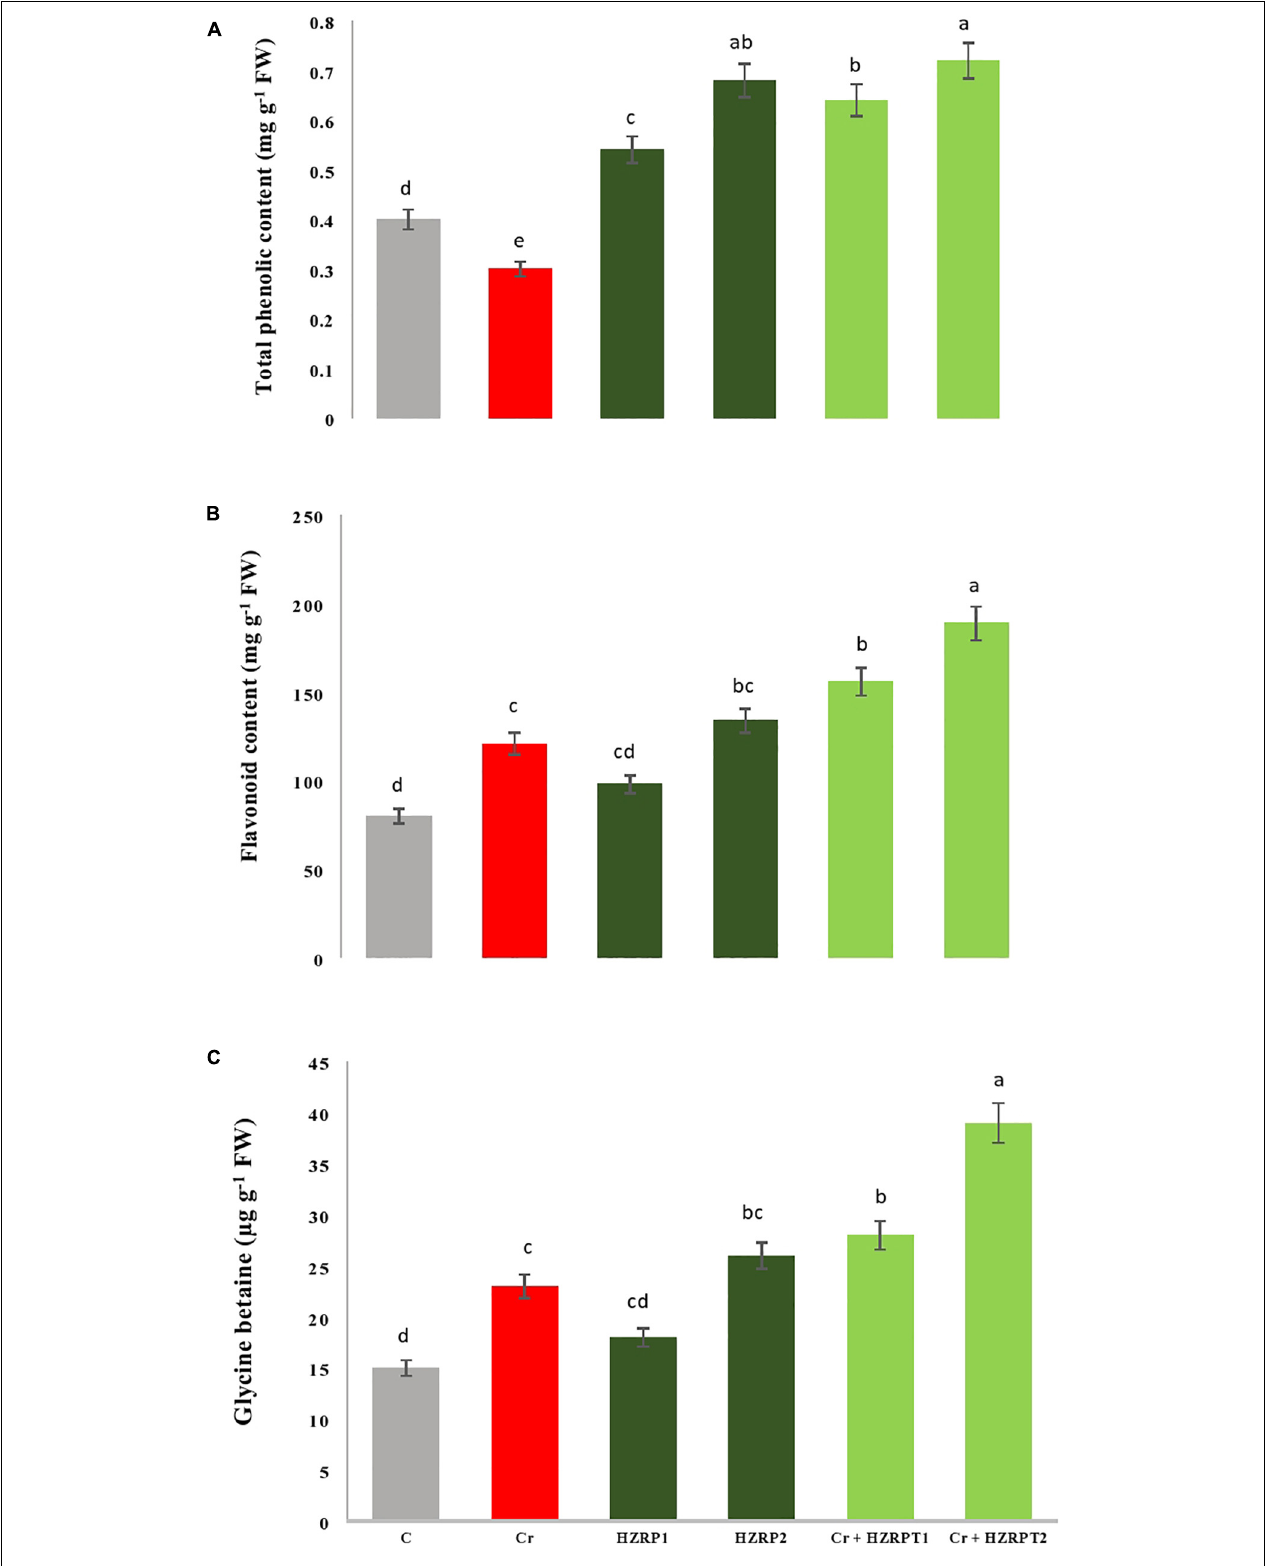
FIGURE 4 | Effect of HZRP on total phenolic content (A) , flavonoids (B) and glycine betaine (C) content in V. radiata seedlings grown in C T toxificated soil. Different letters indicate significant difference among the treatments ( p < 0.05). Cr, 50 mgkg − 1 , H7.RP1, 1 p.p.m; HZRP2. 2 p.p.m.